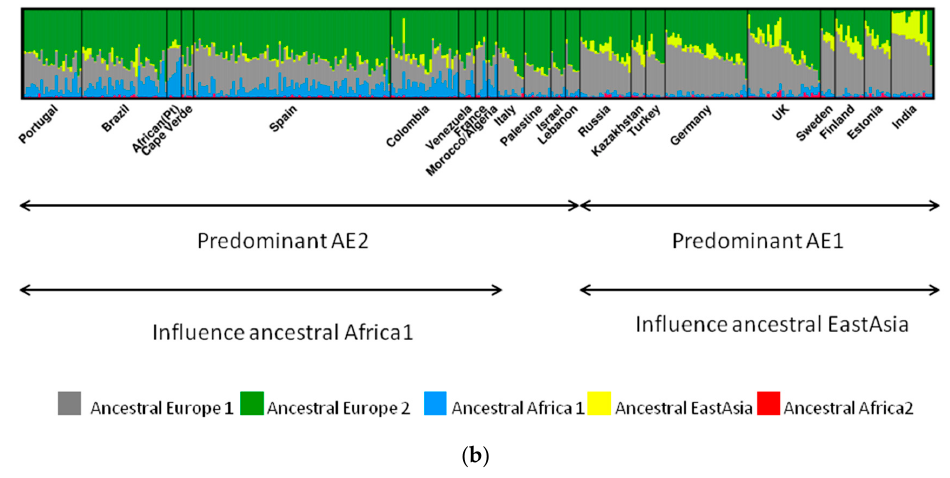
Figure 2. Ancestral populations of H. pylori . Each vertical line represents a strain. ( a ). General ancestral populations of H. pylori . Modern H. pylori populations result from the admixture of 6 ancestral populations (adapted with permission from [22]); ( b ). Detailed ancestral populations found in Europe. All hpEurope strains are recombinants of AE1 and AE2, but southwest Europe strains are additionally a product of recombination with ancestral Africa1 (adapted with permission from [29]).